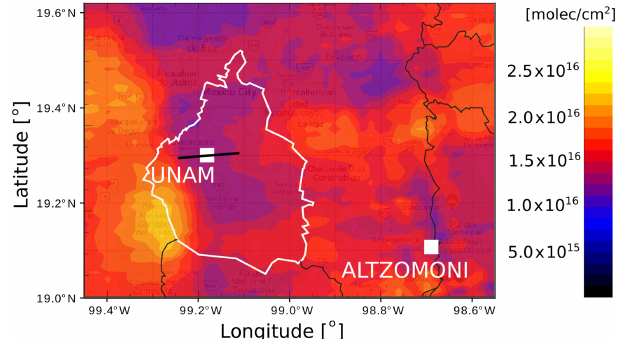
Figure 4. Average HCHO total column distribution map over the MCMA between 2005 and 2018. The columnar HCHO distribution is reconstructed from OMI measurements on board the Aura satel- lite with a daily Mexico City overpass at around 14:00LT (spatial distribution is only representative for this time). Color bar units are in molec.cm − 2 . The UNAM and Altzomoni measurement sites are marked with a square; the region comprising Mexico City is indi- cated in white; and the measurement directions are indicated with a black line over the UNAM